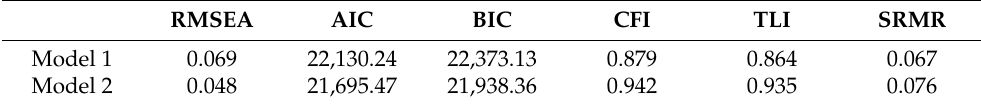
Table 5. Goodness of fit of the models. RMSEA AIC BIC CFI